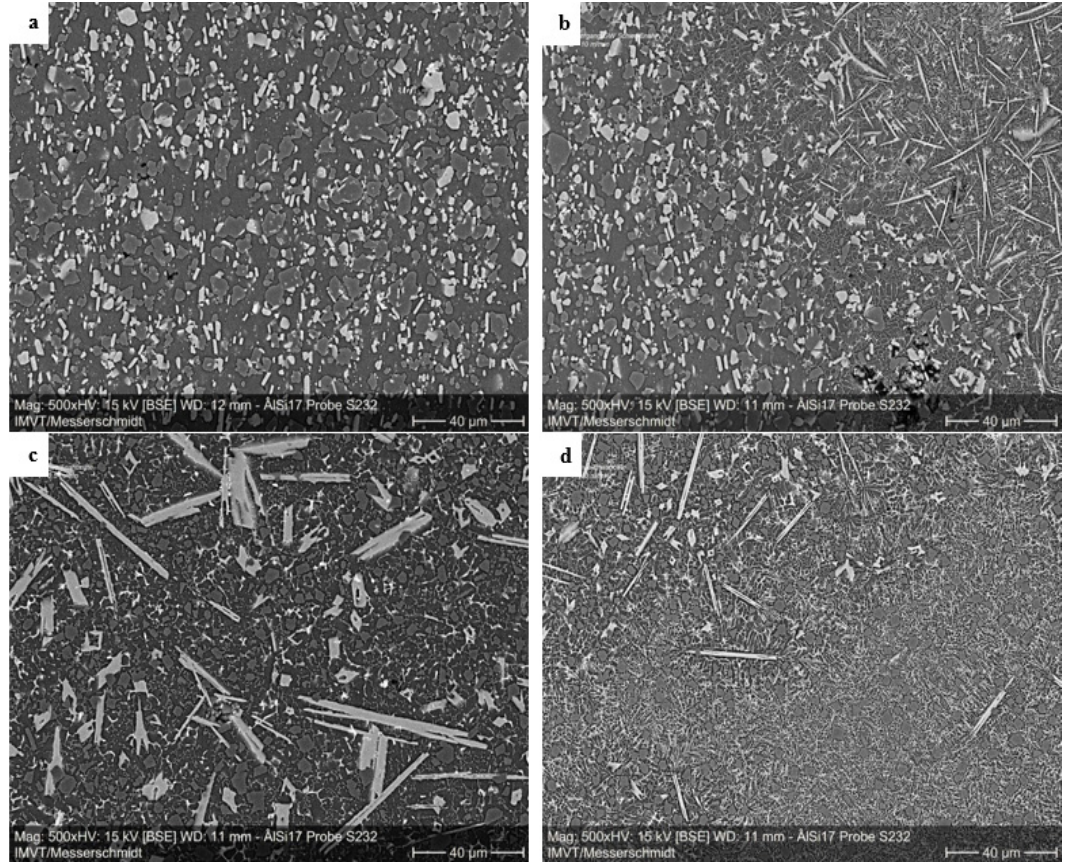
Figure 8. S232: ( a ) Base material; ( b ) Transition of weld seam to base material; ( c ) Center of the weld seam for v = 0.5 m/min; ( d ) Center of the weld seam for v = 10 m/min.